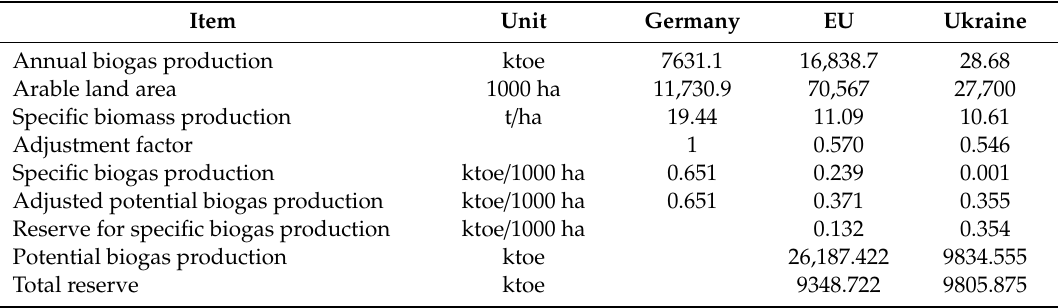
Table 2. Selected biogas production indicators in Ukraine, Germany, and the EU. Note: toe, tons of oil equivalent.